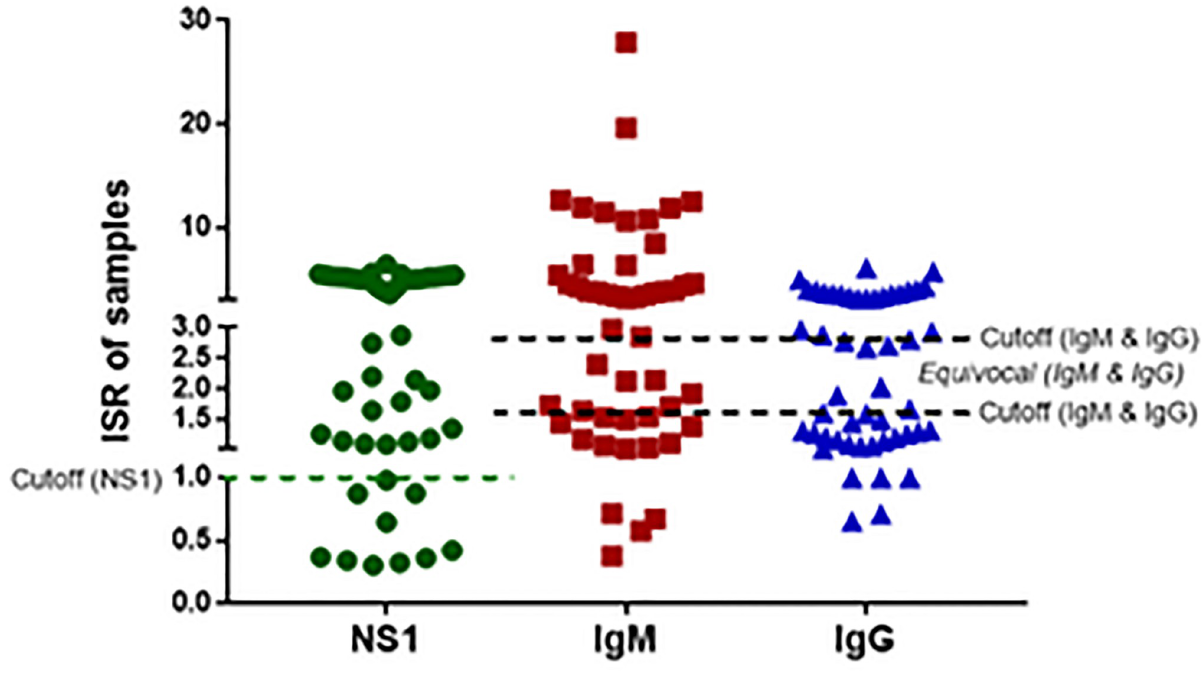
Fig 3. NS1 antigen, anti-DENV IgM, and anti-DENV IgG serostatus of the 50 patients with suspected dengue. The dotted lines represent the cut-off values for positive and negative status for NS1 or positive, negative, and equivocal status for IgM and IgG. ISR, immune status ratio.